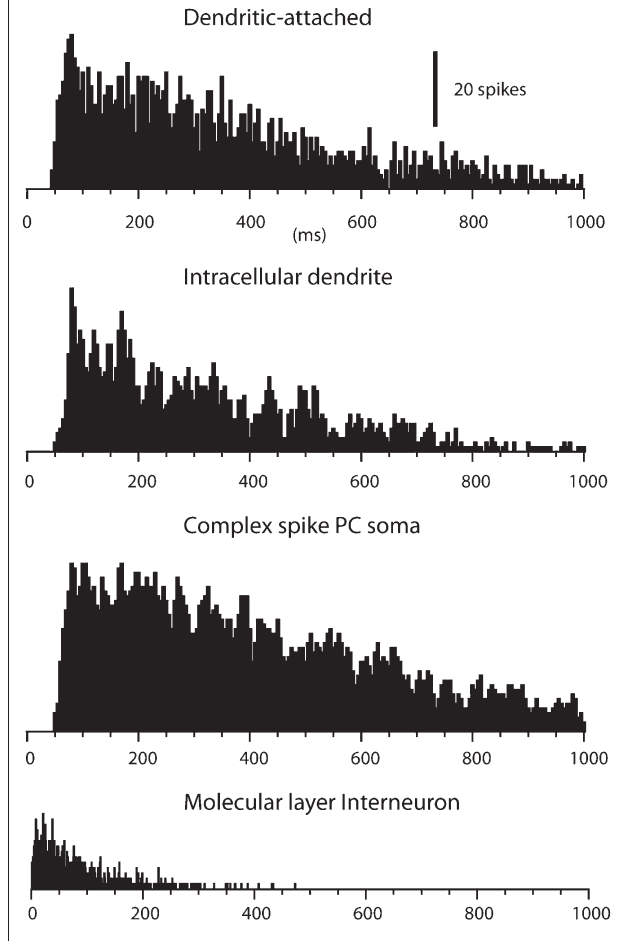
FIGURE 2 | Spike interval-frequency histograms for dendritic and complex spikes. From the top, this fi gure shows the spike interval- histograms of a single unit dendritic spike, extracted from a double loose patch dendritic recording, of a dendritic spike in an intradendritic recording, and of a complex spike in a PC soma recorded extracellularly with a metal electrode. For comparison, the lowermost histogram plots the spike interval distribution of a molecular layer interneuron. Bin widths, 5 ms, except in lowermost histogram, which has a bin width of 1